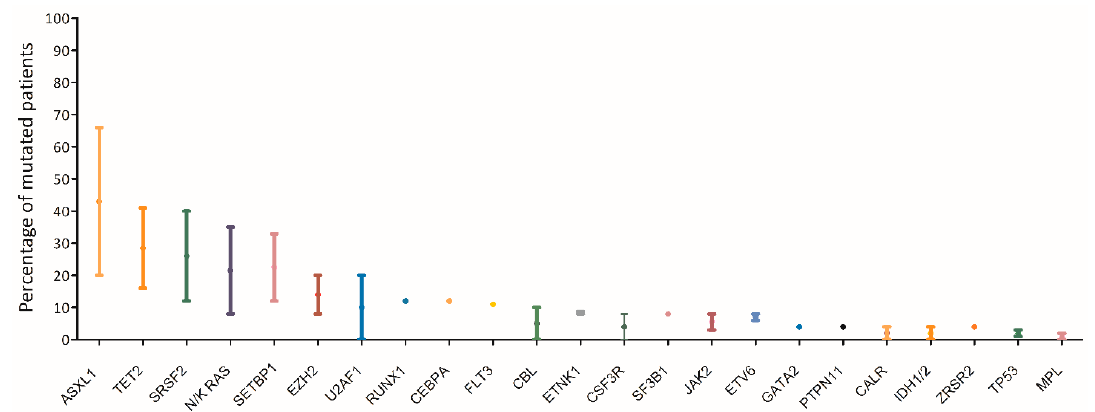
Figure 3. Mutational landscape of aCML. The main genes found to be mutated in aCML are represented on the X axis of the graph. Bars represent the minimum and maximum percentage of mutated patients for each gene reported in different study populations [1,2,8,18–22].